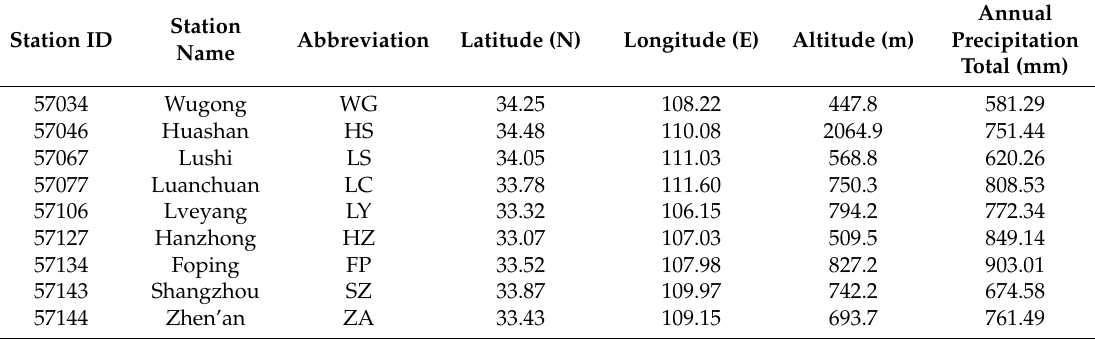
Table 1. List of 25 stations and associated characteristics in the Hanjiang River Basin